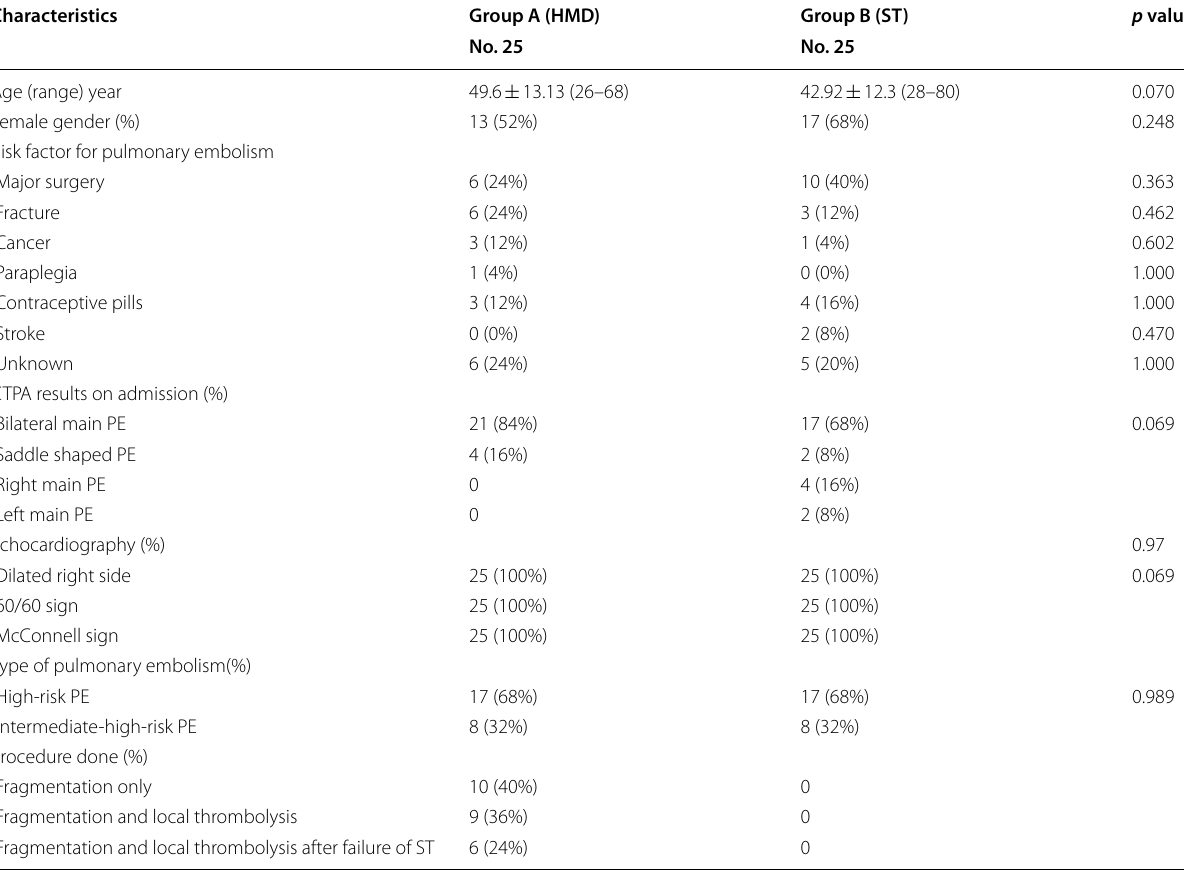
Table 1 Clinical, demographic and investigational characteristics of the study